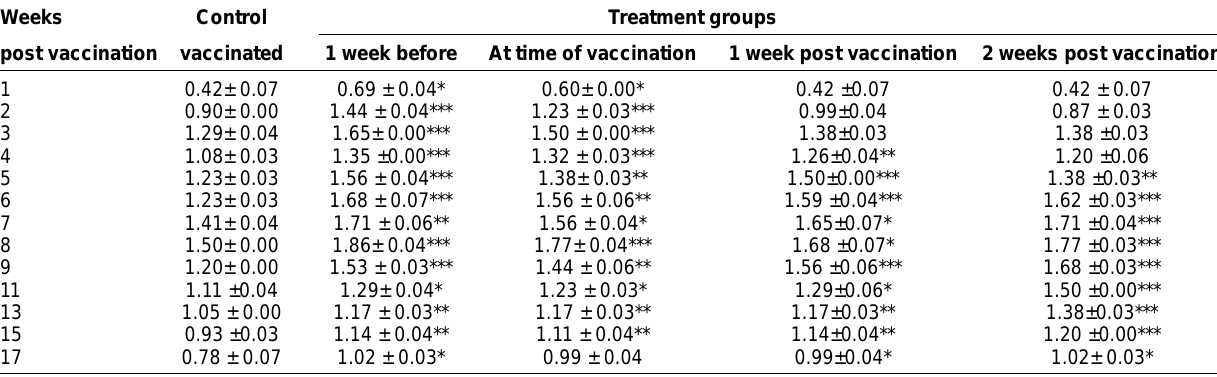
Table-6. Effect of intramuscular injection of Imidocarb dipropionate (3mg/Kg b.wt.) on the serum neutralization antibody titre expressed by Log10 in anaplasmiod- infected calves vaccinated with FMD vaccine (±S.D.,n=5).